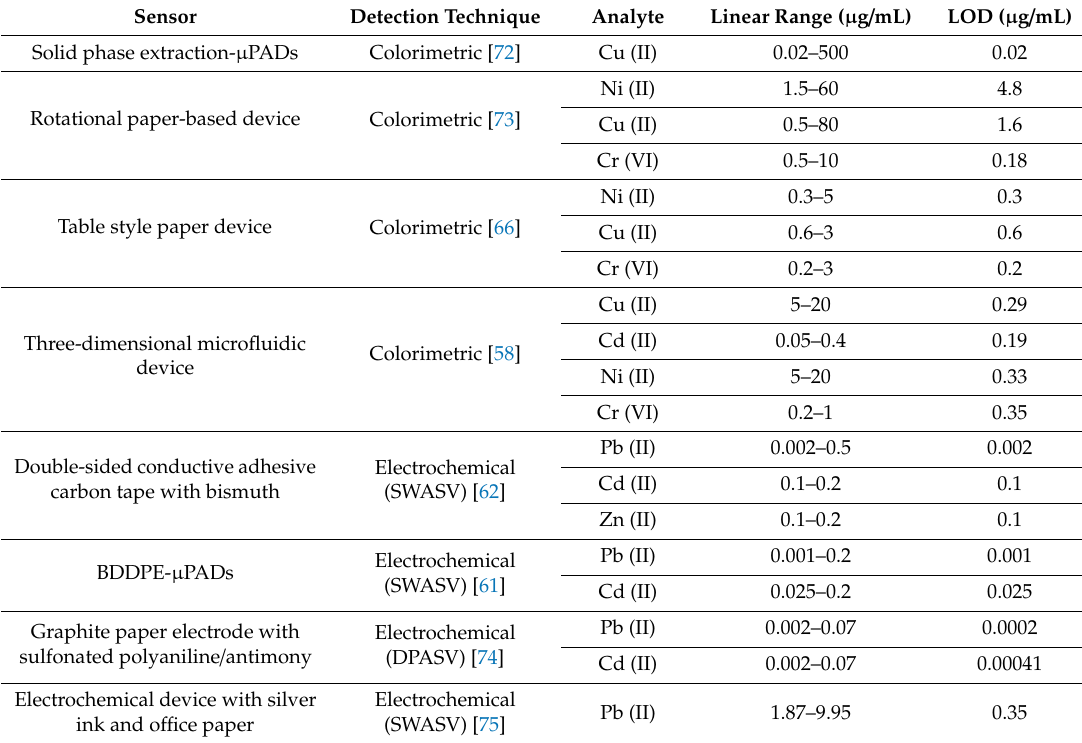
Table 2. Analytical characteristics of other paper devices described in the